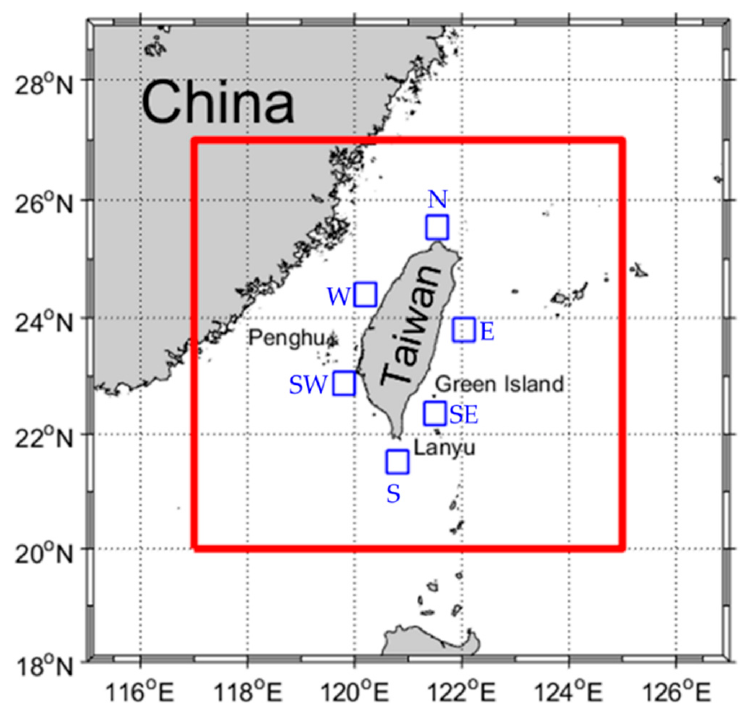
Figure 1. The inside of the red square is the study area. The blue squares are the areas selected for the discussion of DINEOF performance.